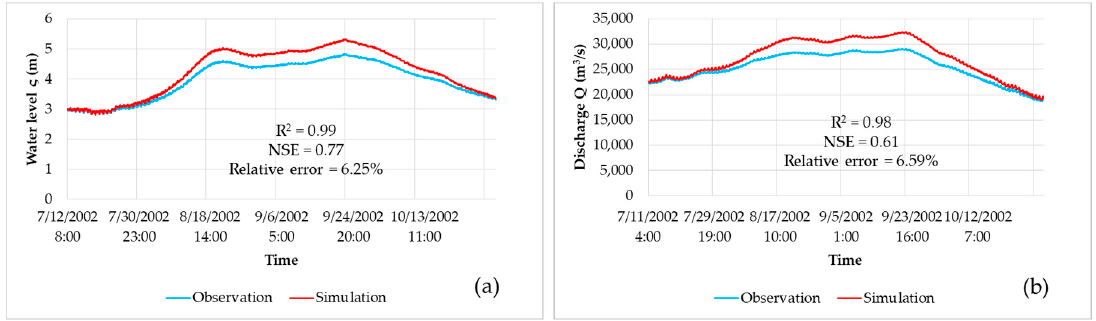
Figure 5. Calibration results at Tan Chau station from 11 July 2002 to 30 October 2002 for water level ς (m) ( a ) and discharge Q (m 3 /s) ( b ).